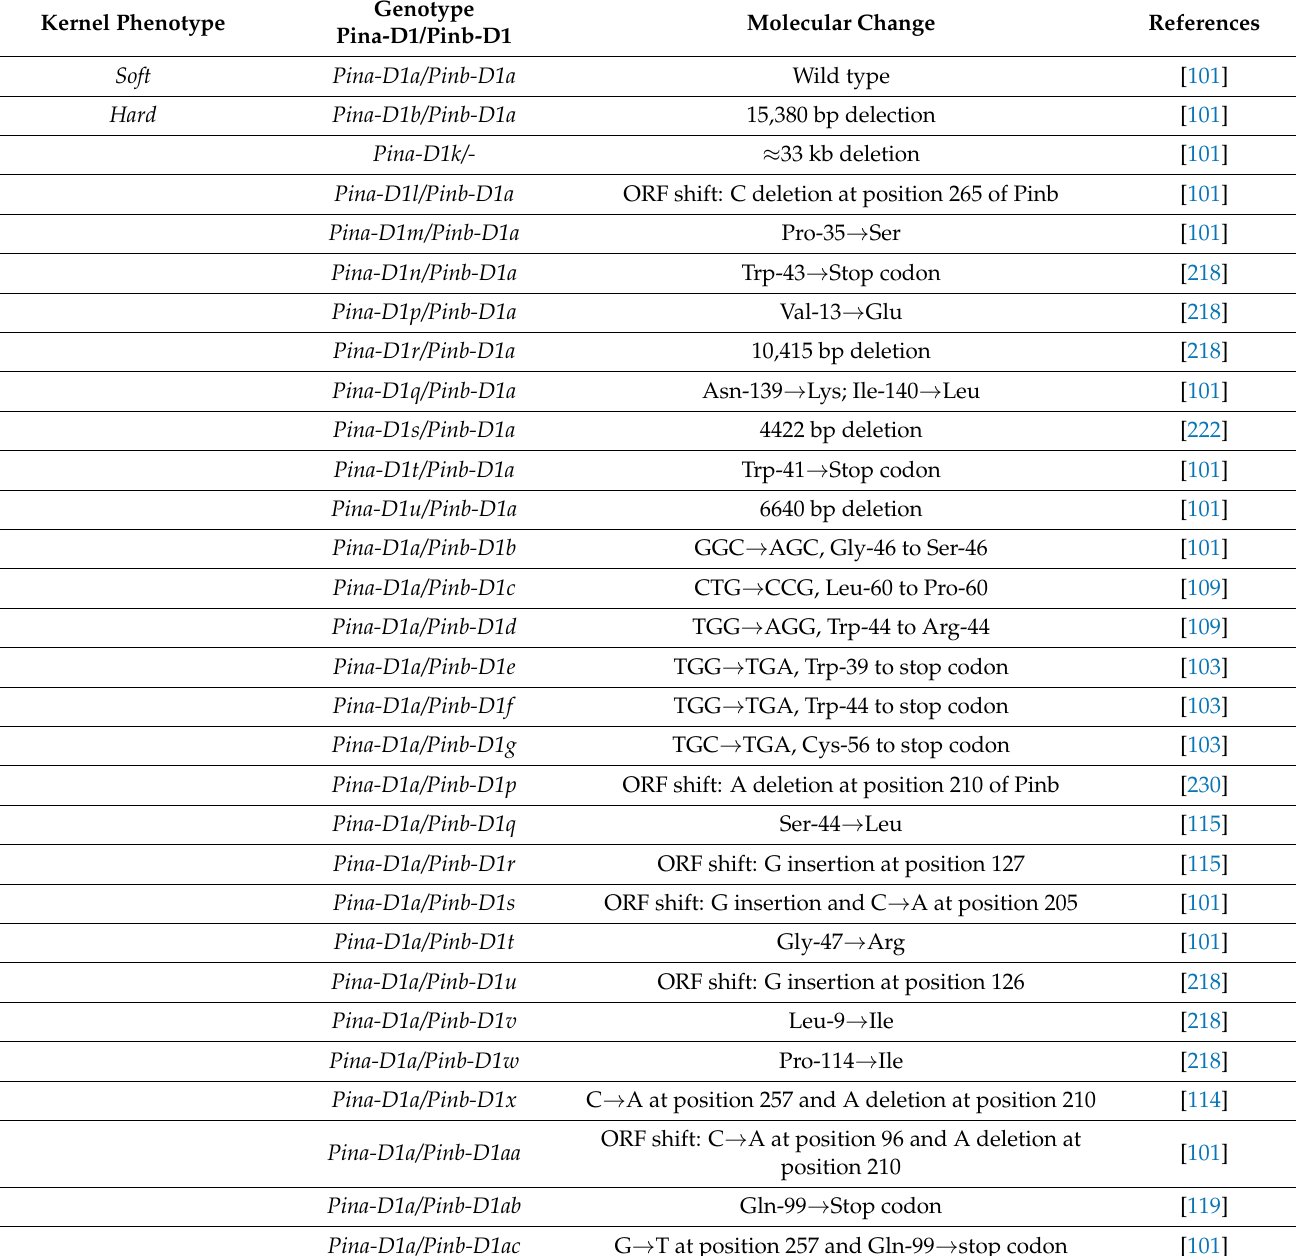
Table A3. Examples of puroindoline—D1 alleles, kernel phenotype, genotype, and the molecular changes in the puroindoline DNA and protein